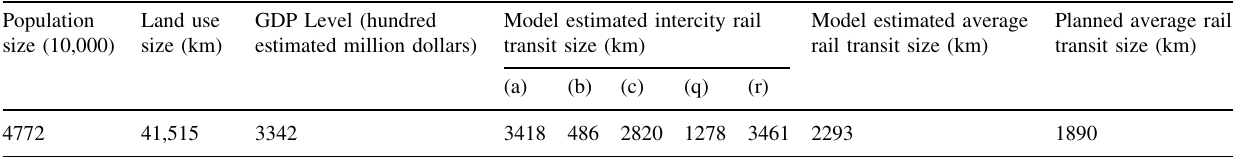
Table 2 Comparison between estimated and planned total rail transit lengths Population size